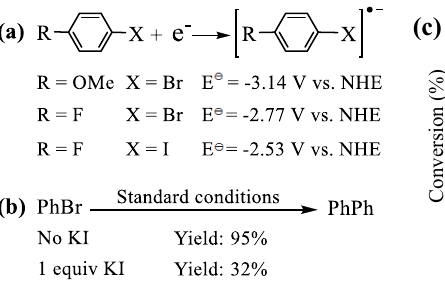
Fig. 6 | Effect of substituents or halogen ions. a Standard redox potential (E) of phenyl halides with different substituents. NHE represents a normal hydrogen electrode. b Effect of I - on the reaction. For standard conditions, see Fig. 5. c Time